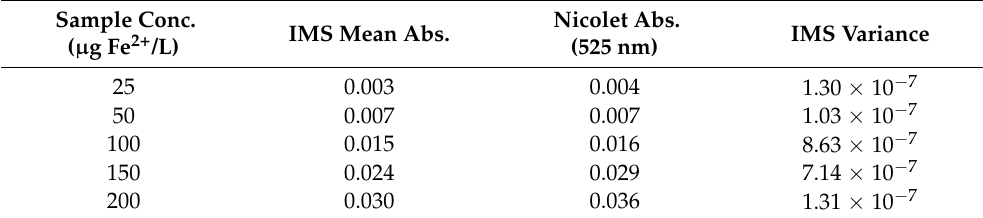
Figure 14. ( a ) Calibration curve of Fe 2+ for developed solid reagent using IMS instrument for concentrations ranging between 25 and 200 µ g Fe 2+ /L in distilled water; ( b ) calibration curve of Fe 2+ for reference Nicolet Evolution 300 spectrophotometer for same concentration range; ( c ) best fit of absorbances measured with the two instruments for performance comparison. Table 7. Measurements of absorbance in fourth series of iron standard samples. Sample